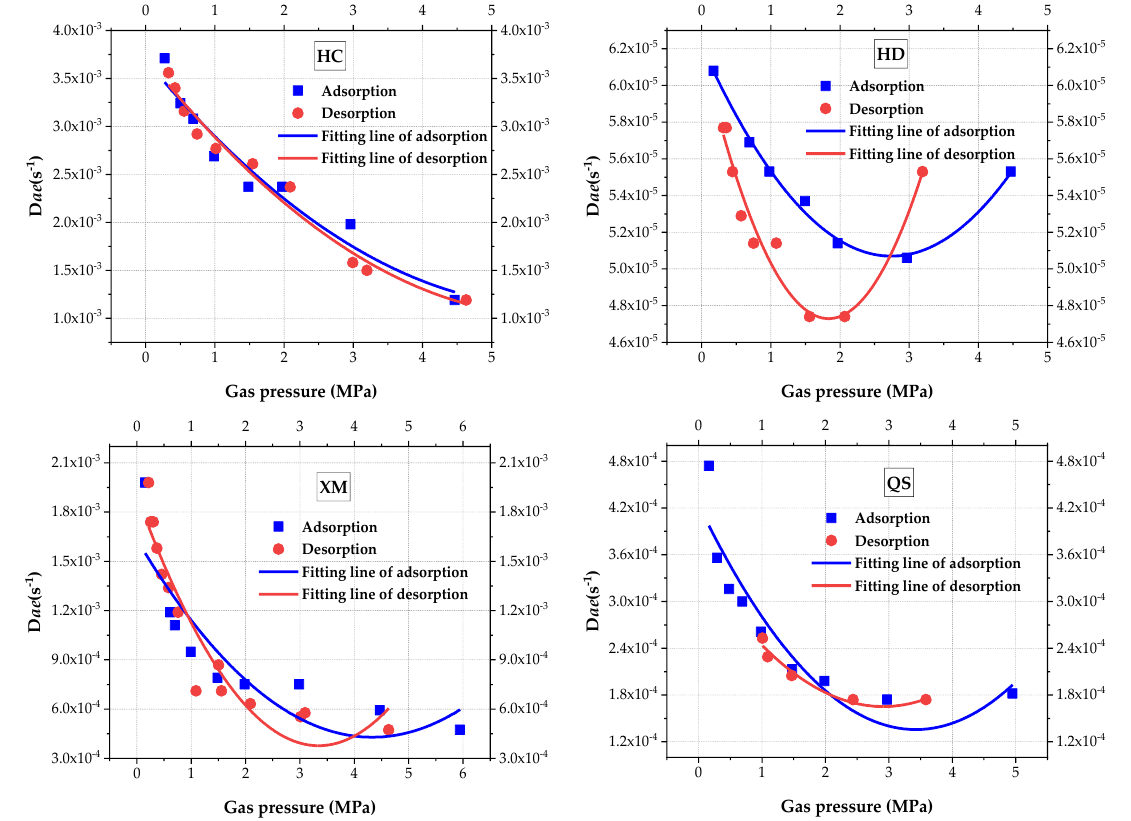
Figure 6. The diagram of the variation of macro-diffusion coefficients with pressure. Table 4. Goodness of fit and diffusion coefficient.